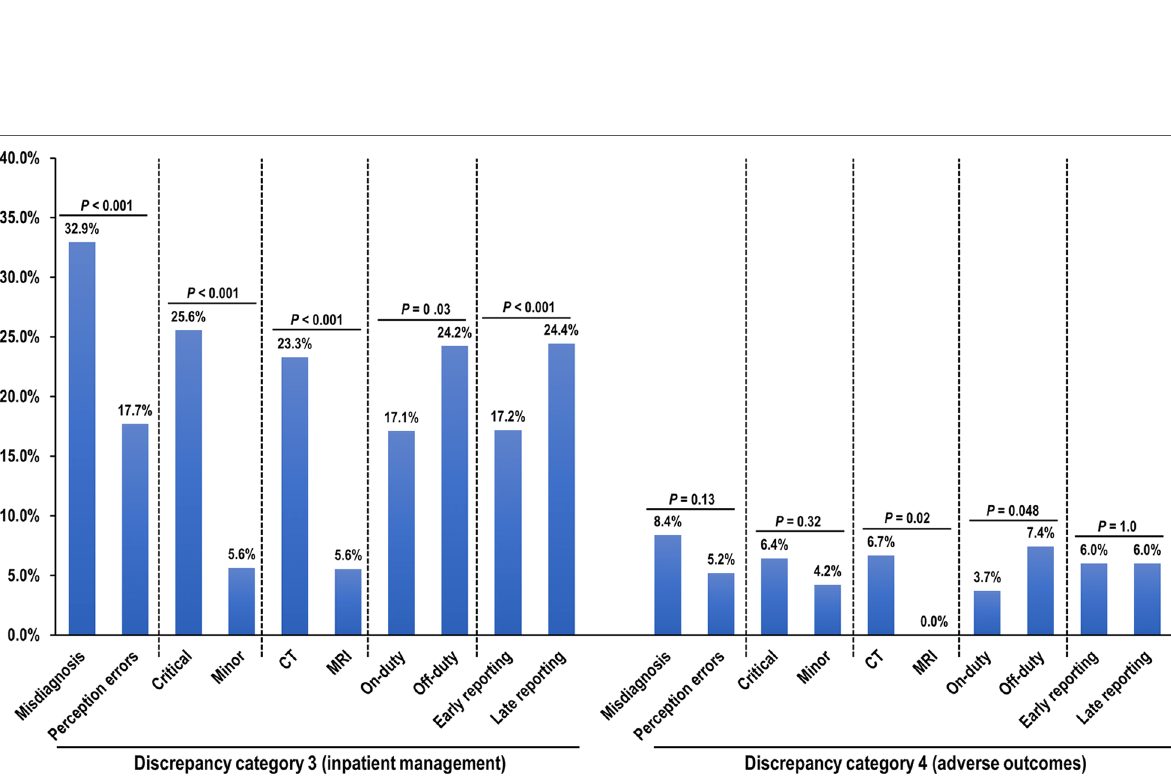
Fig. 3 Incidence of discrepancy category 3 (inpatient management) and category 4 (adverse outcomes) according to various factors associated with radiologic diagnosis. CT computed tomography, MRI magnetic resonance